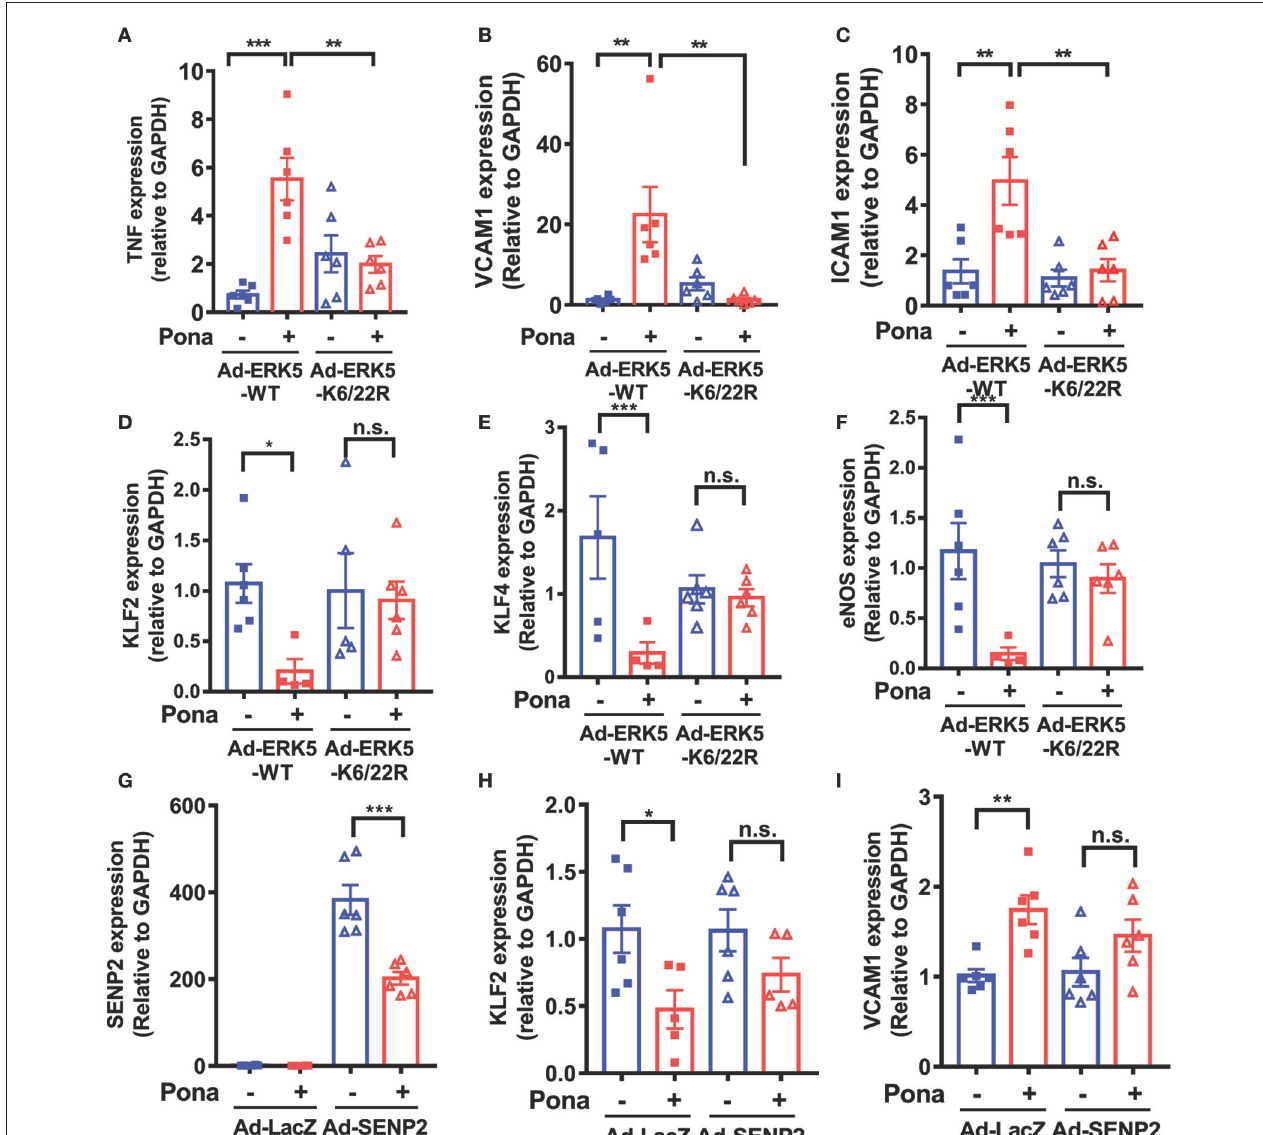
FIGURE 4 | Ponatinib elicits endothelial inflammatory responses via promoting ERK5 SUMOylation. qRT-PCR analysis of relative tnf, vcam1, icam1, klf2, klf4, eNOS, and senp2 in HAECs expressing ERK5-WT or K6/22R mutant (A–F) , and SENP2 (G–I) treated with ponatinib (150nM, 24h). Data set contains 5–6 technical replicates. Error bars represent mean ± SEM. Statistical significance was assessed using ANOVA followed by Bonferroni post hoc testing for multiple group comparison. *** P < 0.001; ** P < 0.01; * P < 0.05 vs.